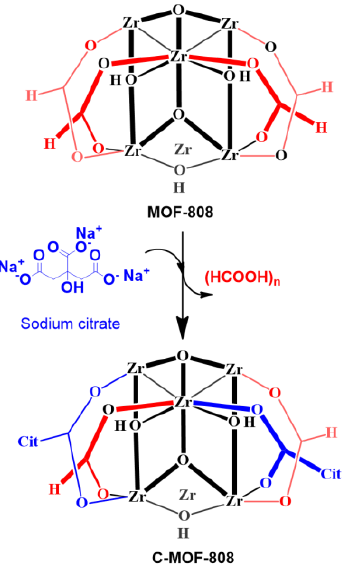
Figure 2. Synthesis of receptor C-MOF-808.